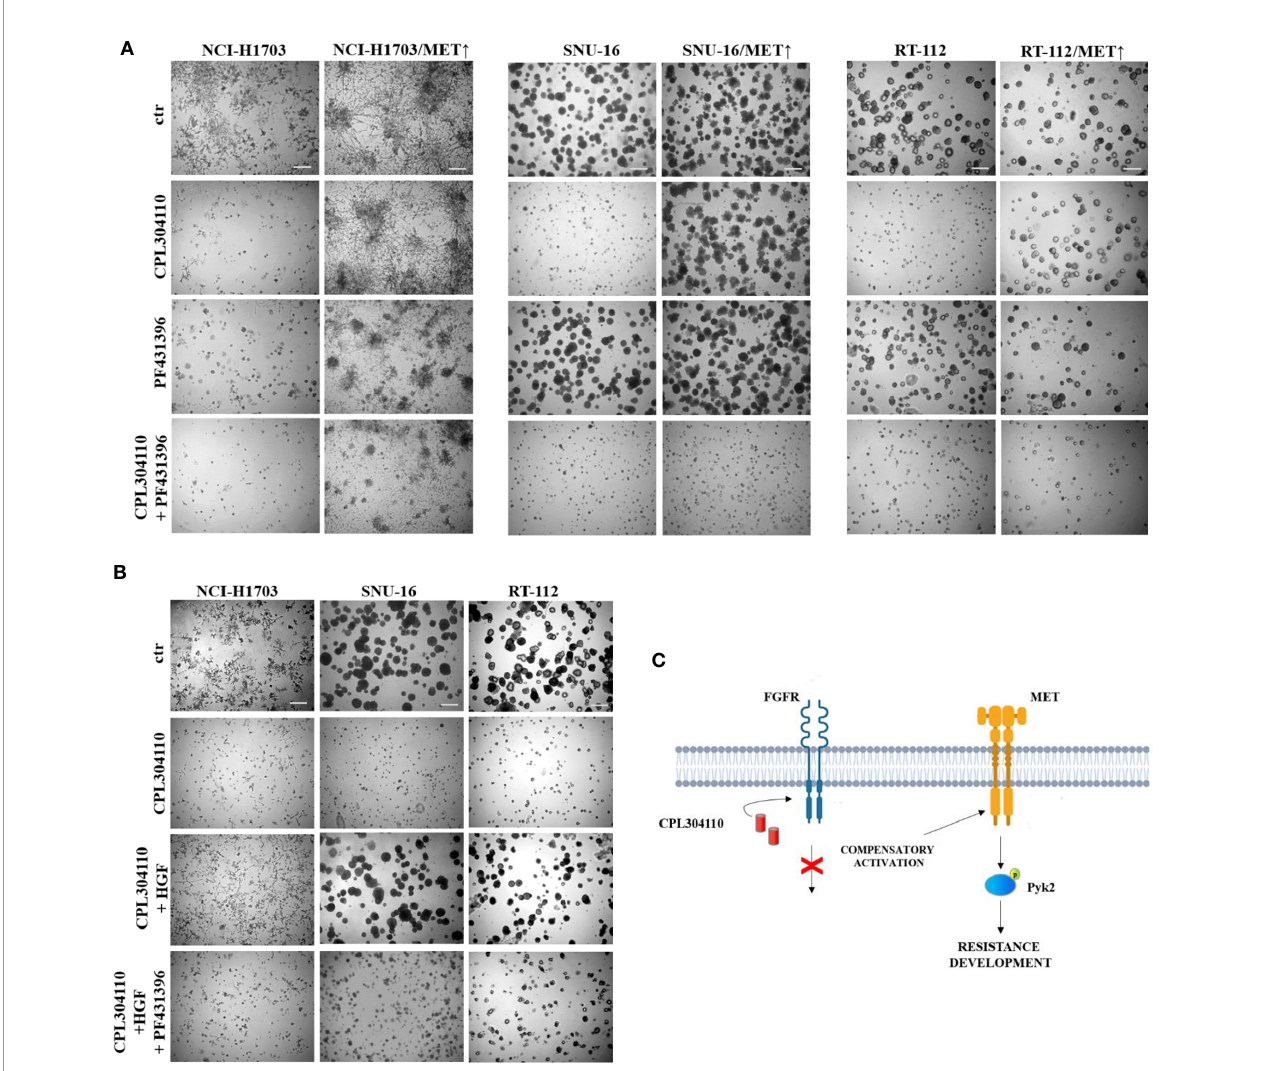
FIGURE 6 | Inhibition of Pyk2 activity restores sensitivity to CPL304110. (A) Parental and MET-overexpressing variants of NCI-H1703, SNU-16, RT-112 cells were grown in 3D Matrigel ® for 14 days in the presence of CPL304110 (1 m M) and/or Pyk2 inhibitor, PF431396 (100 nM). (B) NCI-H1703, SNU-16, RT-112 cells were grown in 3D Matrigel ® for 14 days in the presence of CPL304110 (1 m M), HGF (50 ng/ml), and/or Pyk2 inhibitor, PF431396 (100 nM). Representative pictures were taken, scale bar represents 100 m m, n = 3. (C) Schematic presentation of the proposed mechanism of acquired resistance to FGFR